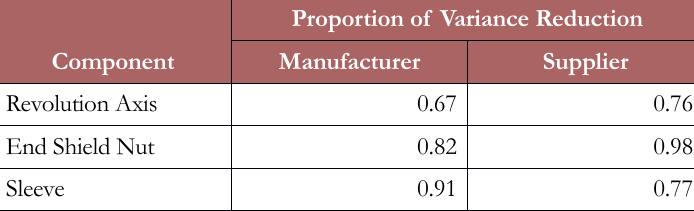
Table 10. Proportion of Variance Reduction at third cycle